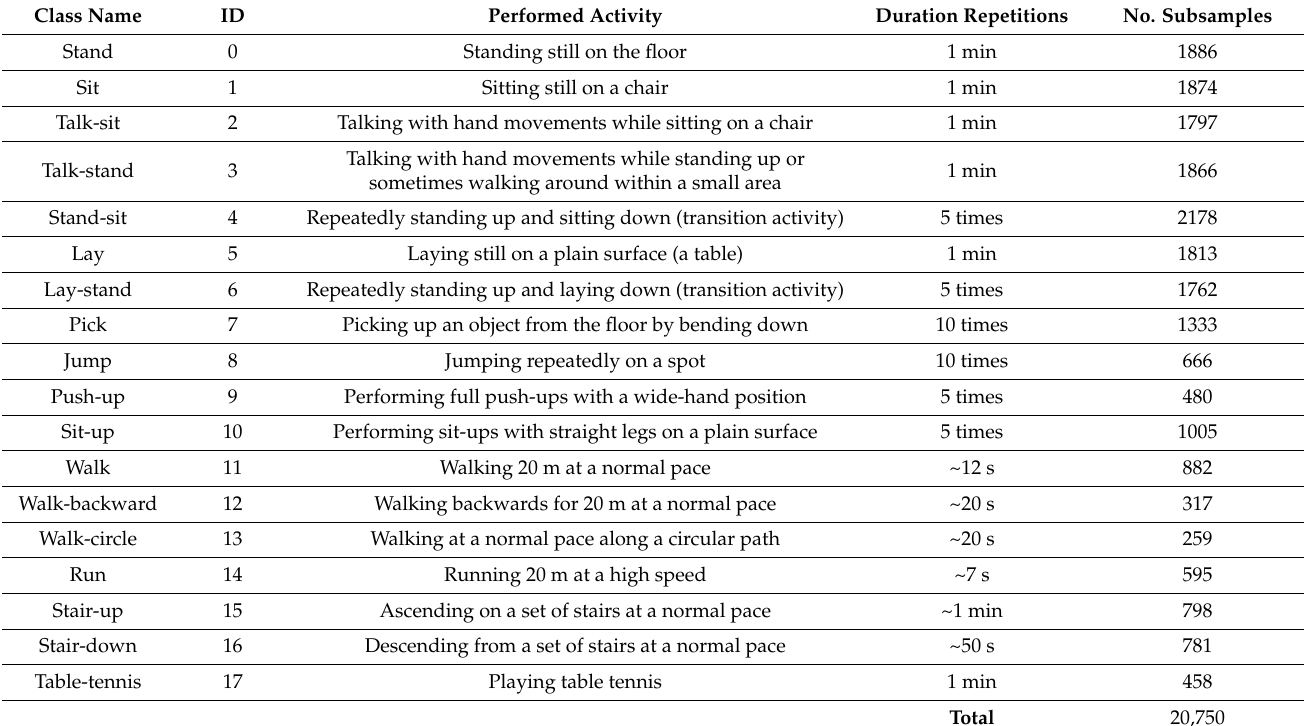
Table 2. Description of the activity classes in the KU-HAR dataset, amended from